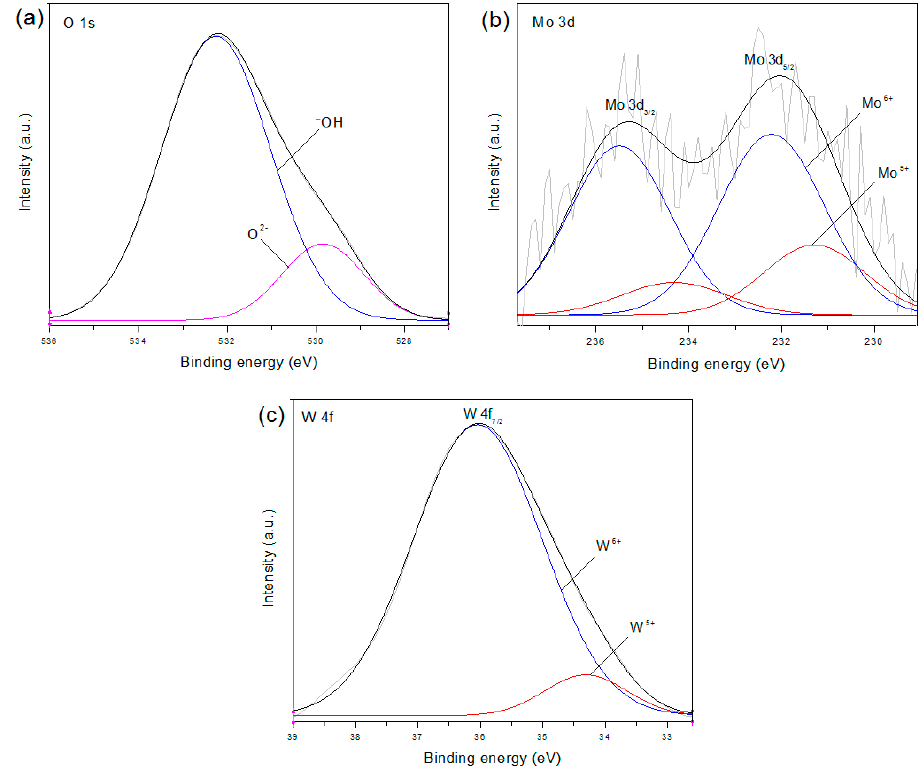
Figure 9. XPS spectra of ( a ) O 1s, ( b ) Mo 3d, and ( c ) W 4f for co-doped TiO 2 sample with W and Mo cations.